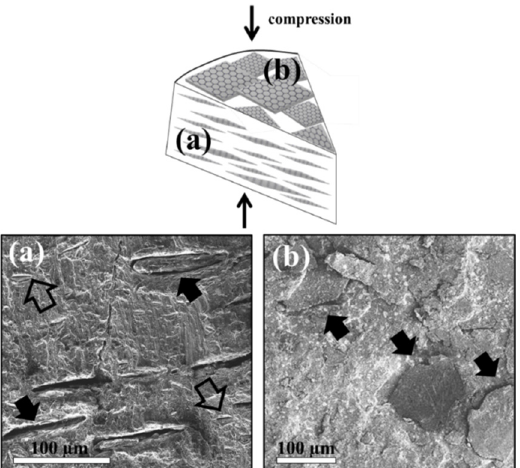
Figure 2. SEM micrographs of rubber loaded with GNP-graphite and CB. ( a ) Cross-section (edge- on): elongated holes indicate pulled-out GNP and graphite (empty and full arrows, respectively). ( b ) Top view (face-on): GNP and Graphite perpendicular to the compression axis (black arrows). The compression vector is indicated in the upper